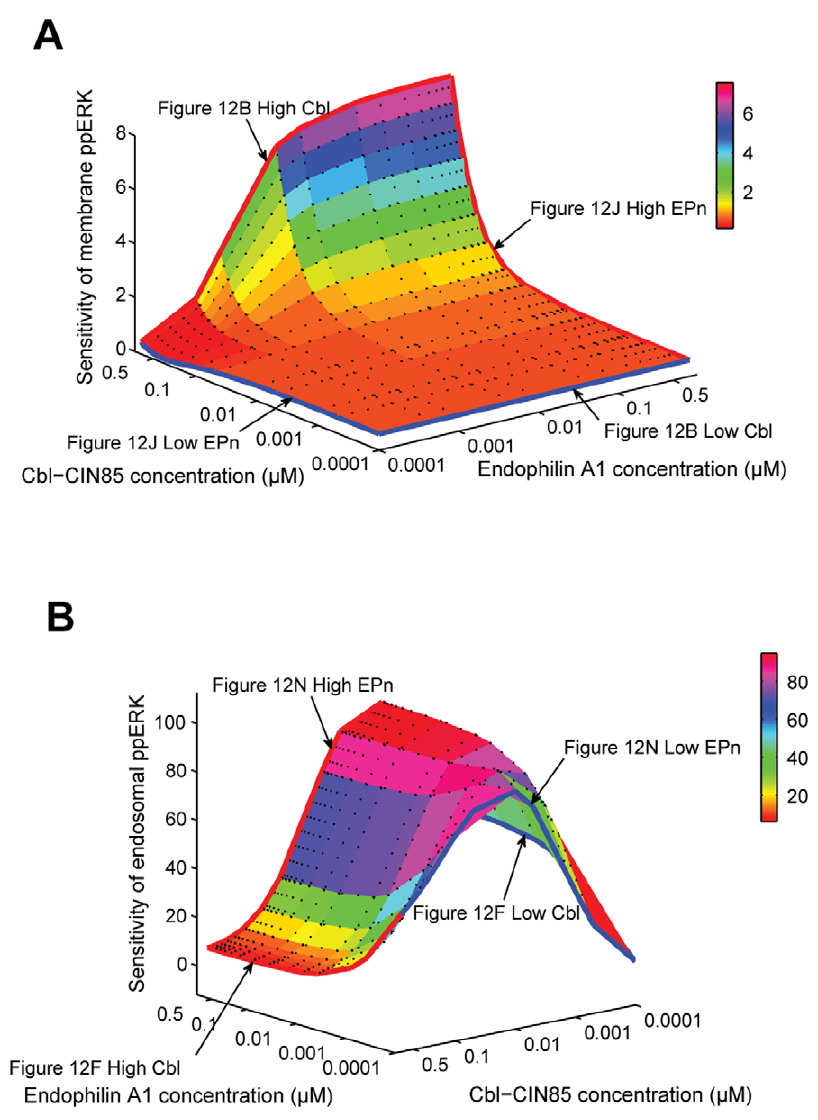
Figure 11. Differential sensitivity of ppERK from (A) membrane and (B) endosomal subpathways for EGF under various Cbl-CIN85 and Endophilin A1 concentrations when scaffold proteins KSR and MP1 are highly expressed – optimal for signaling. For clarity, the sensitivity levels are denoted by colors in the scale bars. Arrows indicate response curves under the conditions specified and detailed in Figure 12, Panels B, F, J, N.